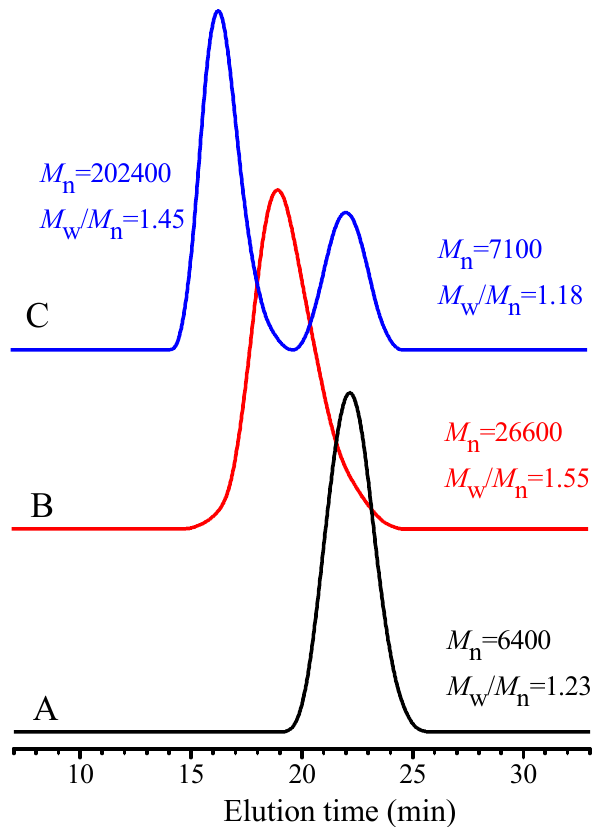
Figure 6. GPC traces of ( A ) the PMMA obtained from the polymerization of MMA with feed molar ratio of MMA/TPPT/AIBME = 50/2/1 in anisole (50 wt %) at 70 °C for 24 h; ( B ) chain extension polymerization of the PMMA ( M n = 6400 and M w / M n = 1.23) was conducted by directly adding the GMA (its dosage is double moles of the MMA used) into the polymerization solution and then was carried out in anisole (30 wt %) at 70 °C for 12 h; ( C ) chain extension polymerization of the PMMA with the GMA (its dosage is double moles of the MMA used) in anisole (30 wt %) at 70 °C for 12 h using PMMA, which was obtained after one precipitation in methanol, as the extender.